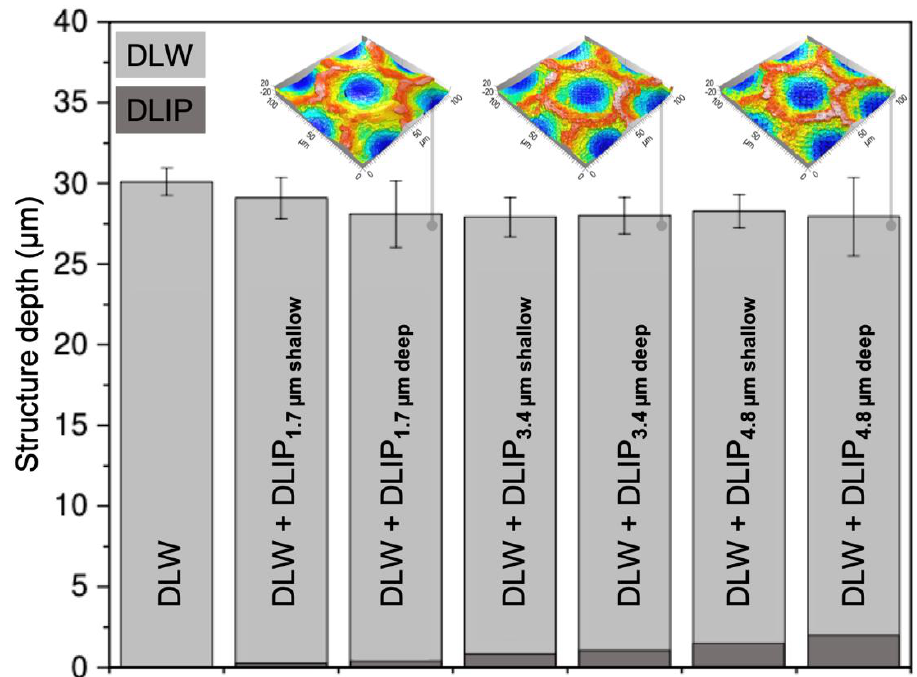
Figure 4. Overview of the structure depths of the DLW structure, the multi-scale DLW+DLIP structures, the DLIP structures within the DLW+DLIP textures as well as exemplary topography images taken with confocal microscopy of the deep multi-scale textures.